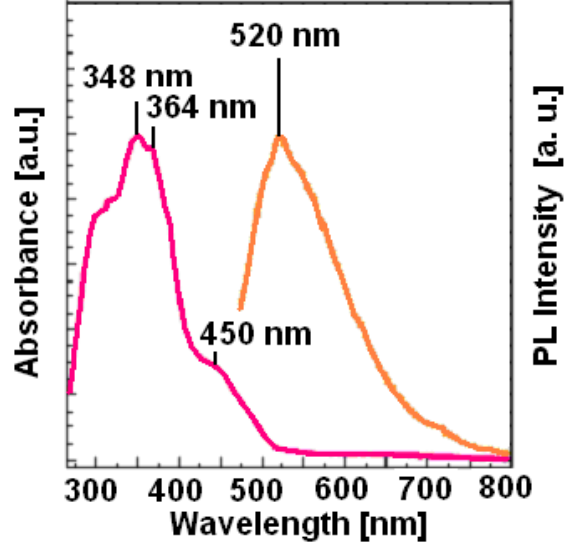
Figure 2. Absorption (UV-vis) and emission (photoluminescence) spectra of the AP1A in THF solution (450 nm excitation